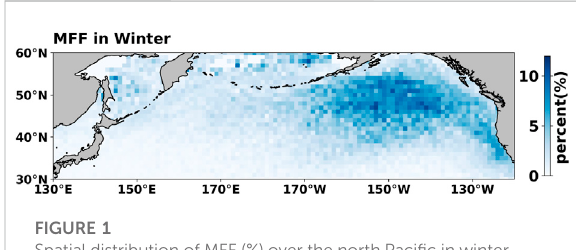
FIGURE 1 Spatial distribution of MFF (%) over the north Paci fi c in winter (derived from the ICOADS